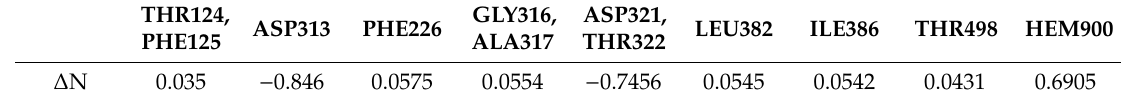
Table 8. Fractional number of transferred electrons ( Δ N) calculated for the interactions between AFB1 and the CYP1A2 protein.